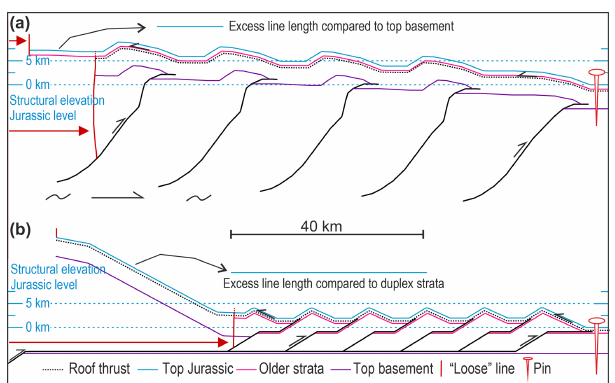
Figure 14. Simplified sketch comparing thick- vs. thin-skinned so- lutions for the structural elevation uplift of the Jurassic level. El- evations are with respect to the regional elevation of the Jurassic (0km); (a) a series of thick-skinned faults with a total of 20km of shortening (16%). Due to the pinning at the deformation front, a roof thrust under the horizons needs to be present. The excess line length of the sediments above the roof thrust (about 13.5km) needs to be accommodated in the section as well, which could happen in internal shortening and amplification of the folds. The solution ex- plains a structural uplift towards the hinterland of 5–7km. (b) One example of a duplex solution with total 48km of shortening (38%). The example solution stays below 5km of structural uplift. In or- der to increase the uplift, more shortening in the duplexes would be required, which would increase the balancing issues. A tentative thrust cutting into the basement behind the duplexes would uplift basement rocks towards the